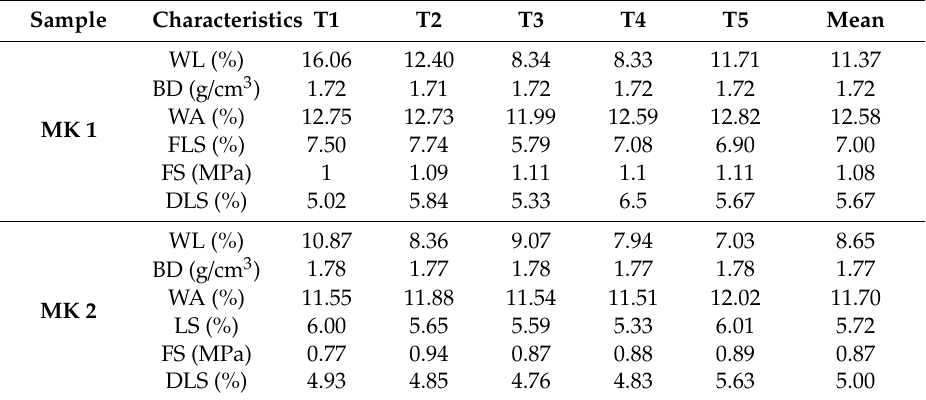
Table 4. Firing characteristics of raw clay